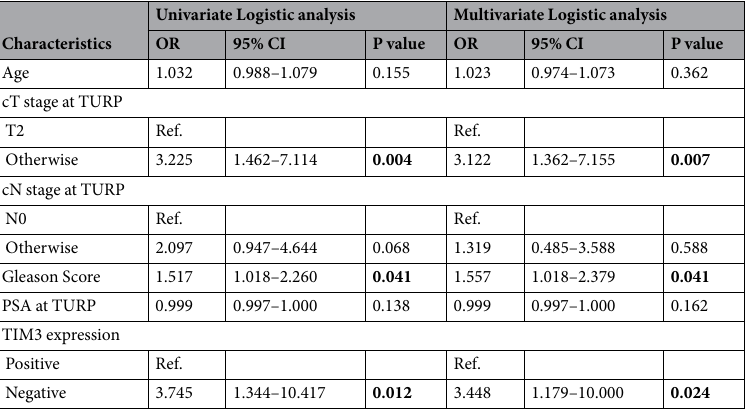
Table 4. Univariate and multivariate Logistic regression analysis of predictors in predicting